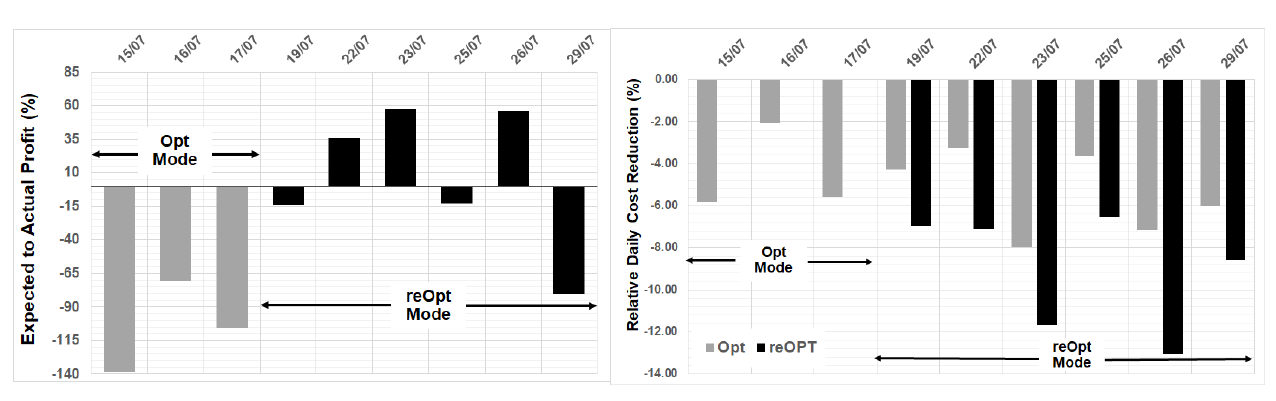
Figure 8. Comparative performance graphs during scenarios A (grey) and B